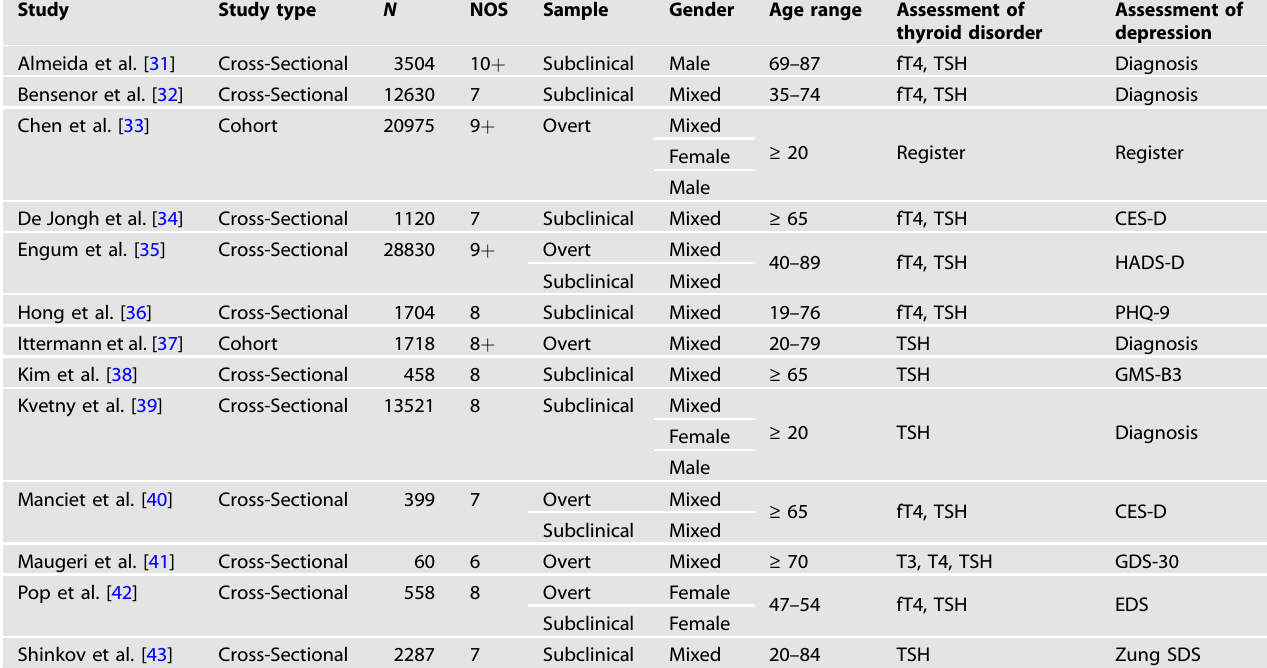
Table 1. Characteristics of studies included in the present